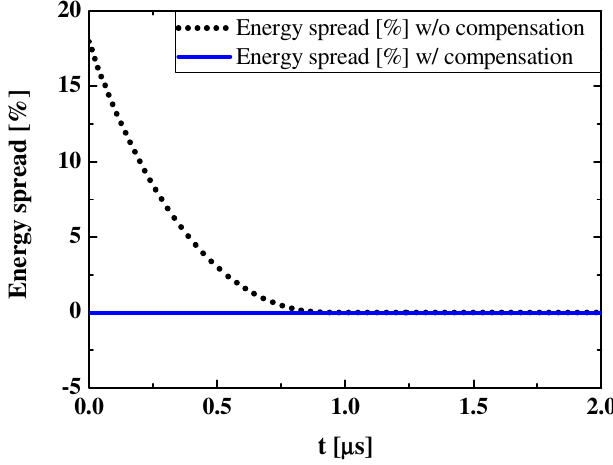
FIG. 11. (Color) Calculated energy spreads without and with compensation.